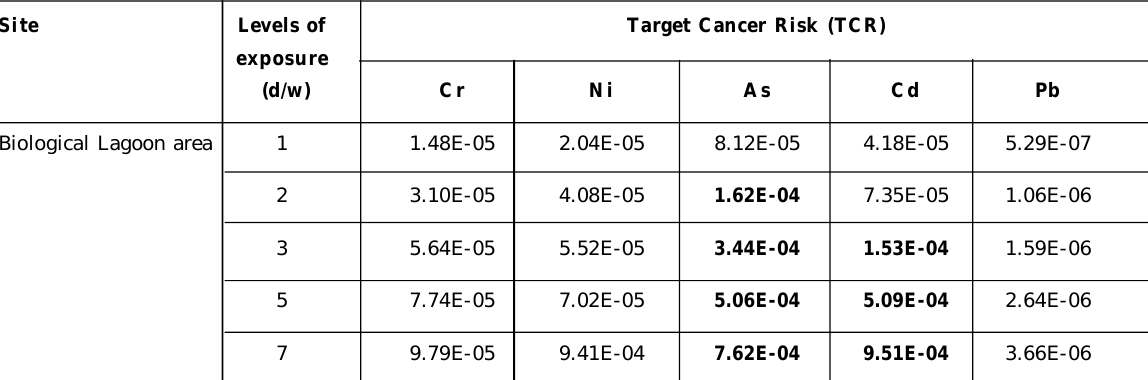
Table 5 Carcinogenic (TCR) health risks of heavy metals due to consumption of potatoes from the study sites